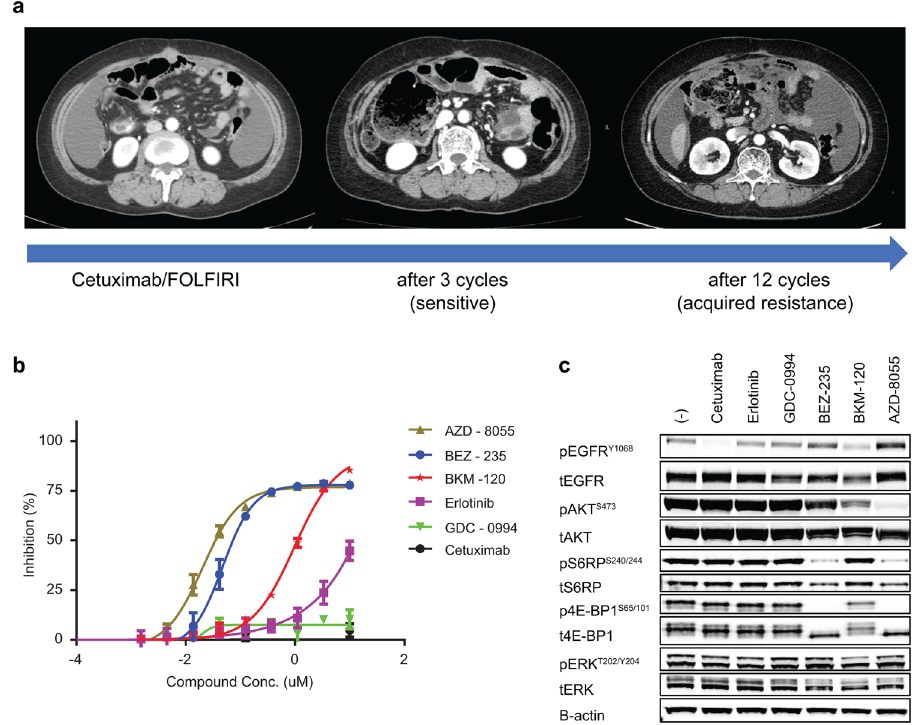
Figure 6. Sensitivity of a patient-derived cell line from patient #4612 to PI3K/mTOR inhibition. ( a ) Computed tomography scans for patient #4612 at baseline and following 3 and 12 cycles of cetuximab treatment. A patient- derived cell (PDC) line was cultured from the acquired-resistant tumour (malignant ascites, which developed following 12 cycles). ( b ) Dose-dependent inhibition of PDC cell proliferation by 5-day treatments with cetuximab (EGFR), erlotinib (EGFR), GDC-0994 (Erk1/2), BEZ-235 (dual PI3K/mTOR), AZD-8055 (mTOR), and BKM-120 (pan-PI3K). Results from four independent experiments are shown. The IC 50 values of AZD- 8055, BEZ-235, and BKM-120 are 0.02, 0.047, and 0.971 µ M, respectively. ( c ) Western blot expression of basal and 24 h treatments of PDC. Cetuximab concentration, 75 µ g/mL; other compounds, 1 µ M. The experiments were repeated